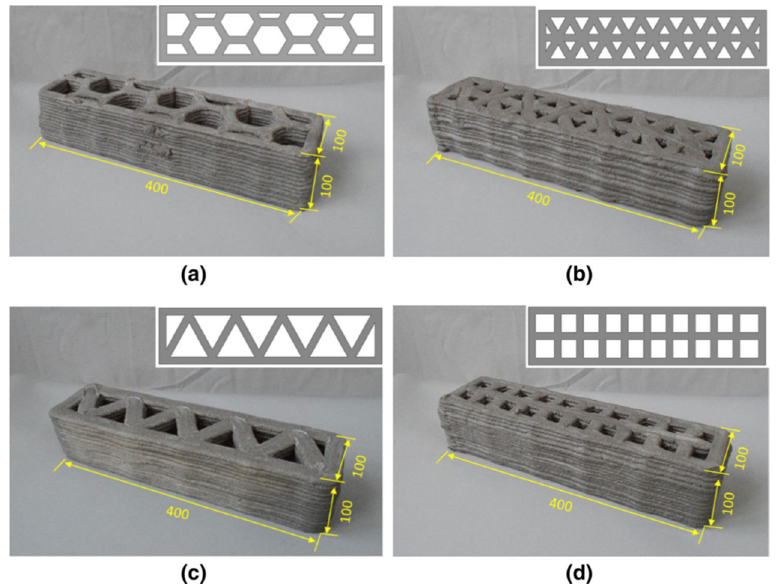
Figure 1. Three-dimensional printed samples: ( a ) cellular; ( b ) triangular; ( c ) truss; ( d ) lattice [24] (unit: mm).